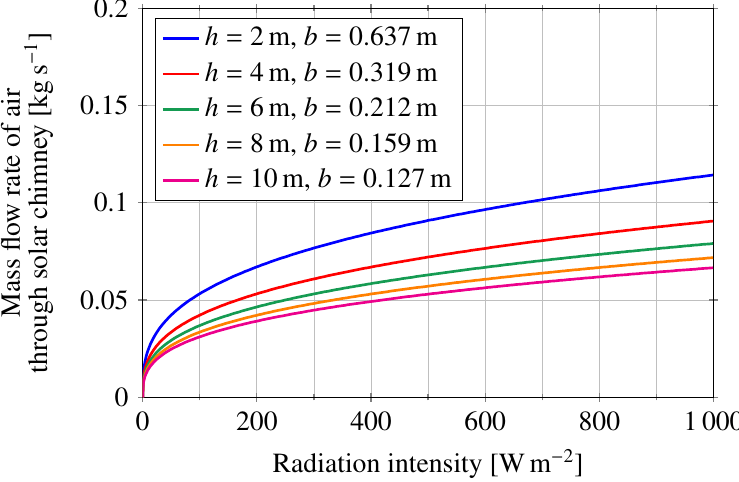
Figure 5. Dependence of the mass flow rate through the solar chimney for various heights.